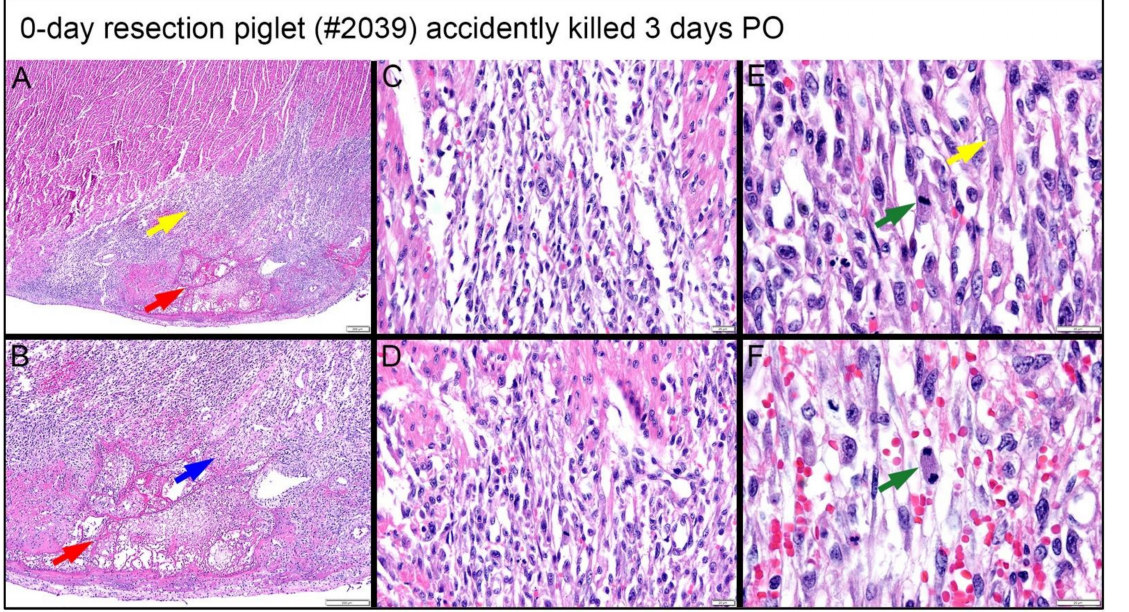
Figure 16. Histological images stained with H & E for the 0-day piglet (#2039) that was accidentally killed by the mother sow three days post apex resection surgery. ( A ) Image of 0-day piglet heart at 2 × magnification; ( B ) Image of 0-day piglet heart at 4 × magnification; the yellow arrow is the border zone of the dense cellular population; the red arrow is fibrin zone/fibrin; the blue arrow is necrotic cardiomyocytes; scale bar = 200 µ m. ( C ) Image of 0-day piglet heart at 20 × magnification; ( D ) Image of 0-day piglet heart at 20 × magnification; scale bar = 20 µ m. ( E ) Image of 0-day piglet heart at 40 × magnification; ( F ) Image of 0-day piglet heart at 40 × magnification; the green arrow is cells with mitotic events; the yellow arrow indicates the cells resembling immature cardiomyocytes; scale bar = 20 µ m. H & E: pink–cytoplasm; blue–nuclei; intense